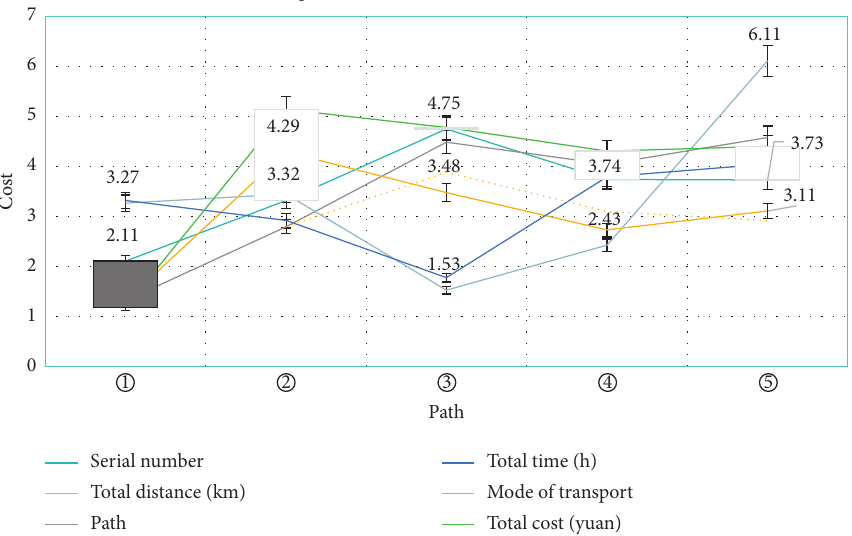
Figure 5: Optimal routes with minimum total cost (not existing time windows).